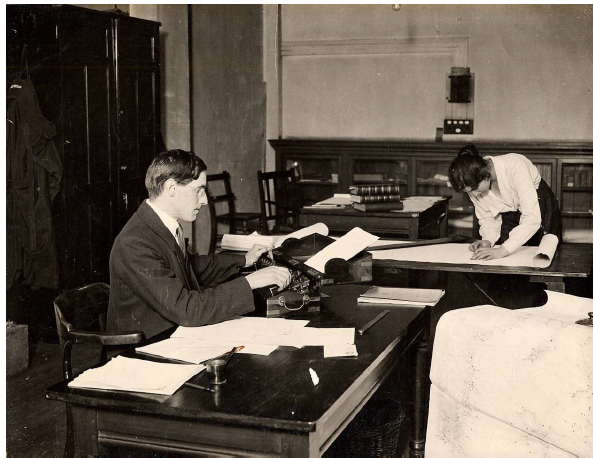
Figure 1. Doodson and one of the computers, Mrs. Dennis, in TI’s room in the Holt Physics Laboratory on the university campus. Pho- tograph used by permission of the National Oceanography